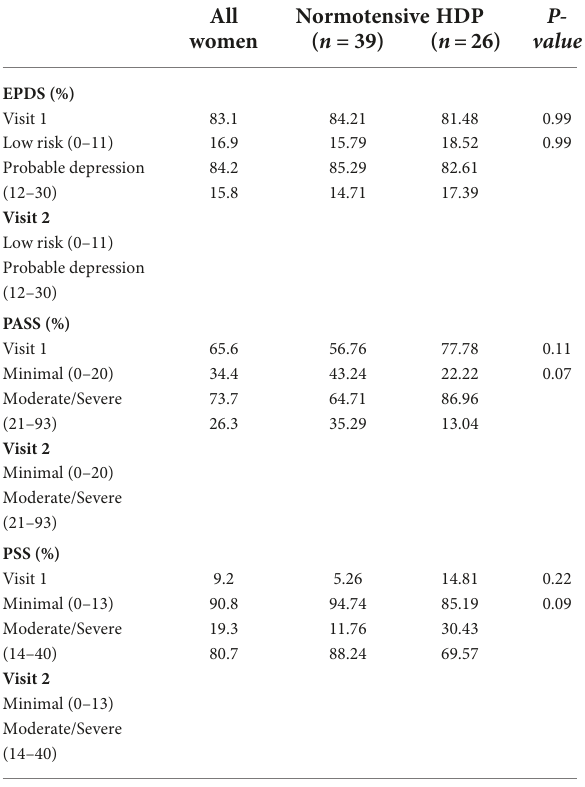
TABLE 3 Scores for EPDS, PASS, and PSS were divided into different categories based on cut-off scores and the number of women were compared between normotensive pregnancies and hypertensive disorders of pregnancy